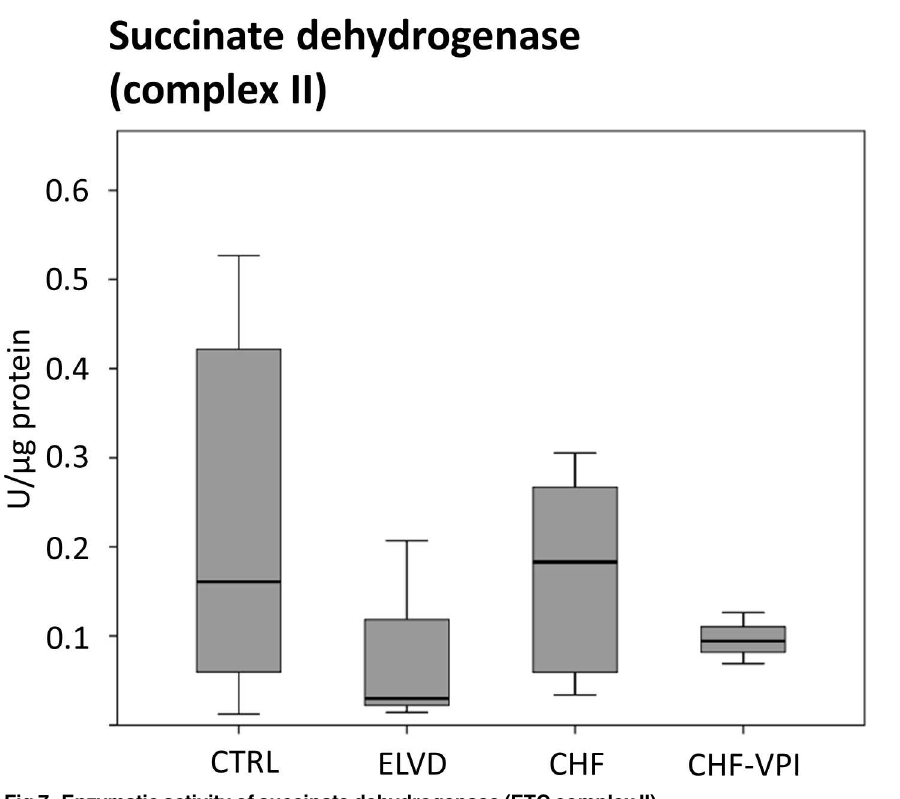
Fig 7. Enzymatic activity of succinate dehydrogenase (ETC complex